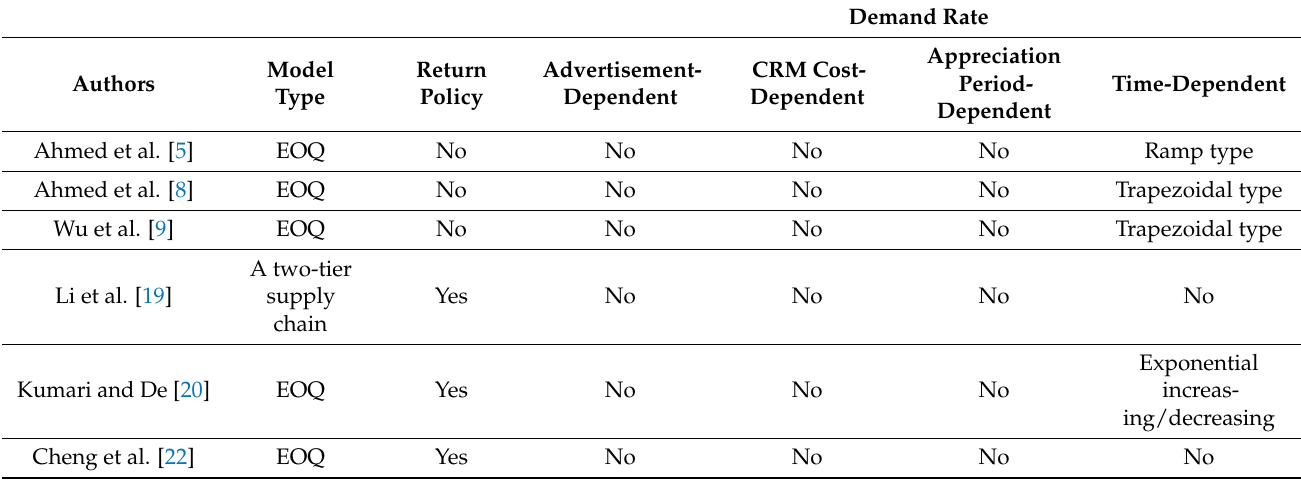
Table 1. A comparison among the present model and related previous